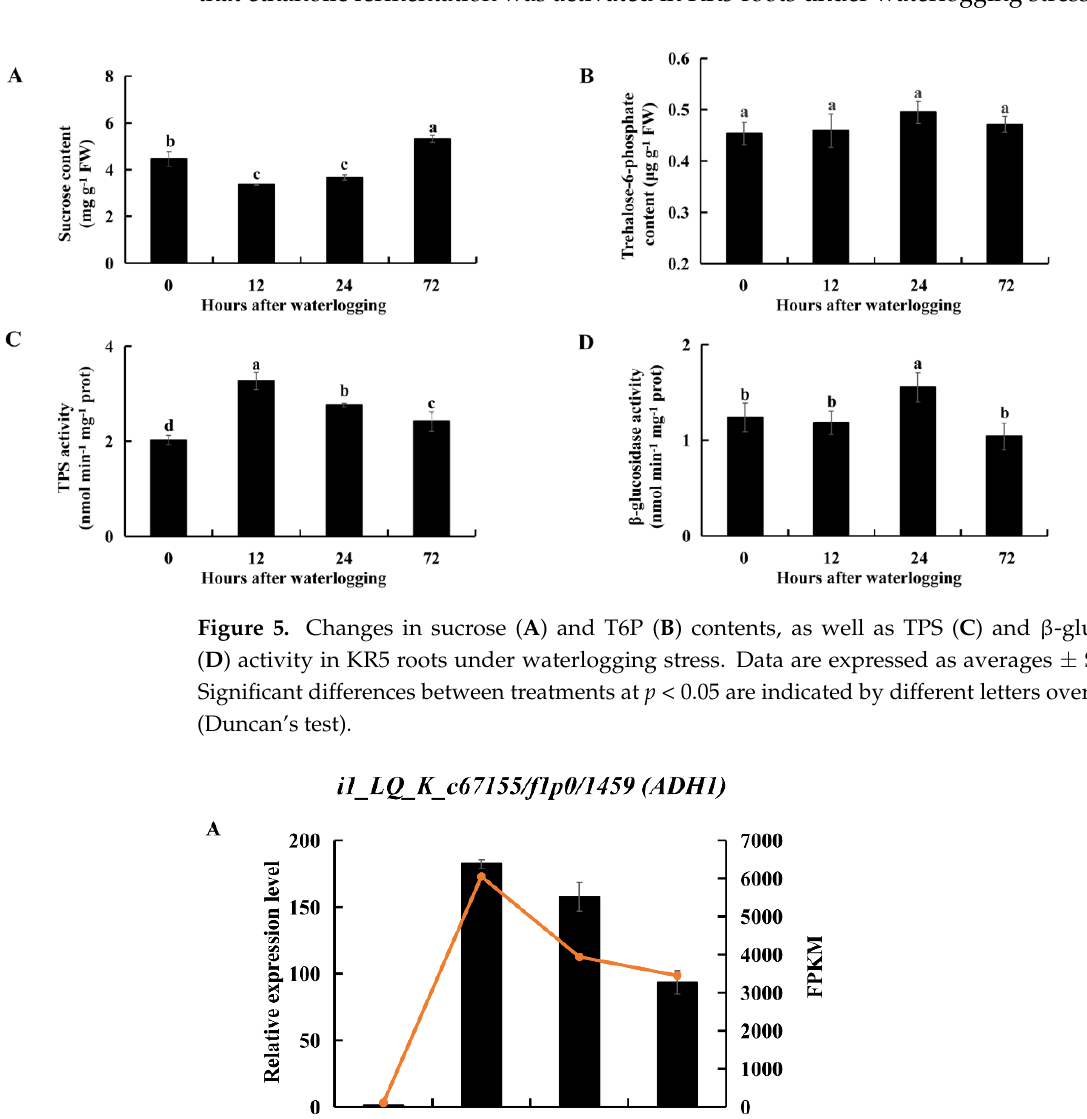
Figure 5. Changes in sucrose (A) and T6P (B) contents, as well as TPS (C) and β -glucosidase (D) activity in KR5 roots under waterlogging stress. Data are expressed as averages ± SD, n = 3. Significant differ- ences between treatments at p < 0.05 are indicated by different letters over columns (Duncan’s test) .